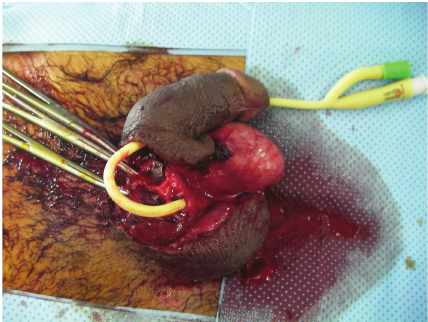
Figure 1: The amputated part is put on an 18F silicone Foley catheter which was passed into the patient’s bladder.